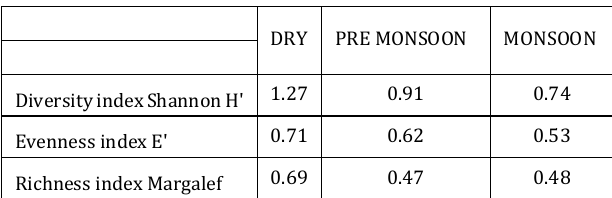
Table 5: Diversity indices at Station 2 during all seasons DRY